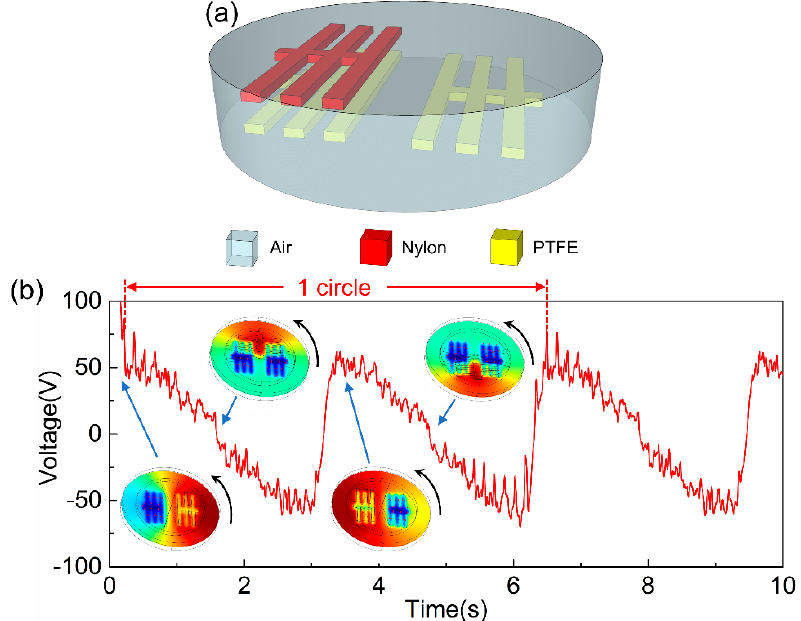
Figure 8. ( a ) The illustration of a 3D disk TENG with a bar type tribo-material. ( b ) The voltage output and electric potential distribution under a 50-M Ω external load.